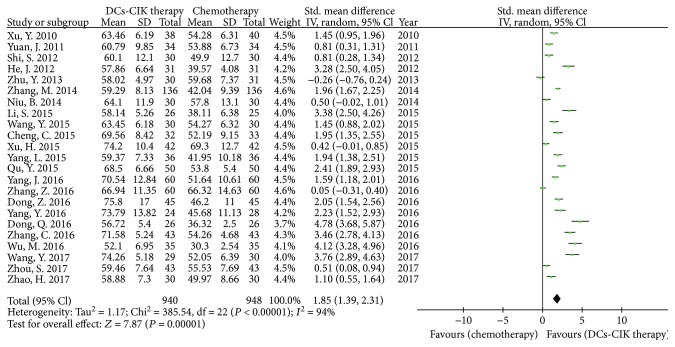
The analysis of CD3+ T cells between the two groups.